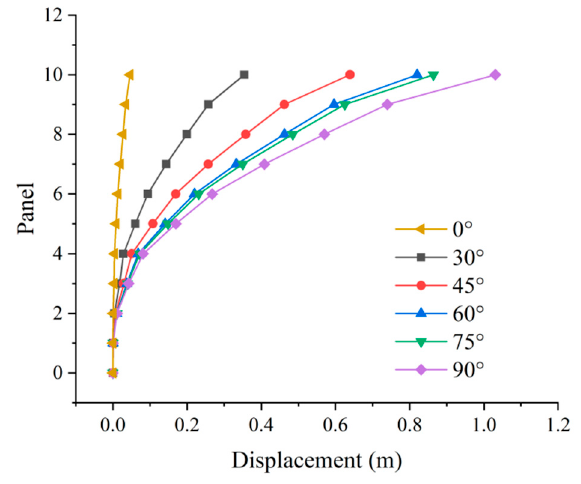
Figure 12. Schematic diagram of the wind attack angle.